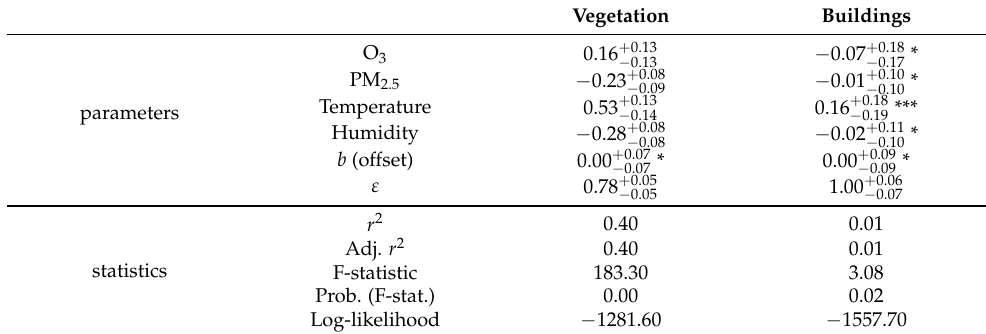
Table 3. Top: MCMC median of atmospheric coefficient parameters to model the SIF indicator ( SIFi ) values at full (848-channel) spectral resolution, together with the 3 σ uncertainty shown as super- and subscripts, which include the full parameter covariance derived from the 3 σ contours in the posteriors provided in Figures 10 and 11. Bottom: Model evaluation statistics for the maximum likelihood solution for vegetation and buildings.